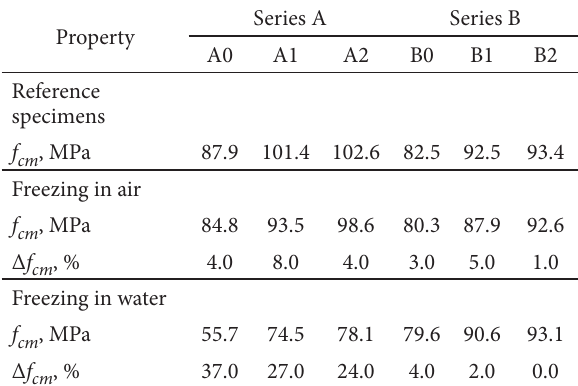
Table 8. Compressive strength f cm after 100 freeze